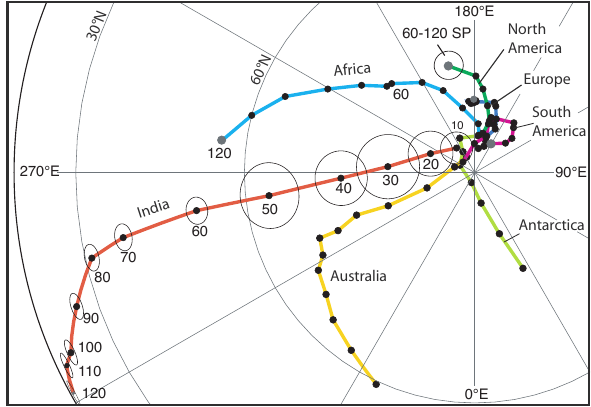
Fig. 2. Apparent polar wander paths for Africa, Antarctica, Aus- tralia, Eurasia, India, North America and South America based on a composite APWP using paleopoles from all the main continents that were brought to common coordinates using finite rotation poles used by Besse and Courtillot (2002), averaged with a sliding 20Myr window every 10Myr, and the mean poles transferred back to the different continents; hence the differences in APWP for the various continents reflect relative motions according to the finite rotation poles used for the plate reconstructions. Mean paleopoles for 10 to 50Ma are from Besse and Courtillot (2002, 2003); mean paleopole for 60 to 120Ma is an average of global igneous data (superpole la- beled 60–120Ma SP with 95% confidence circle and based on 60, 80, 100 and 120Ma mean poles from Kent and Irving, 2010) for a standstill in apparent polar wander in North American coordinates (Table 1). Circles of 95% confidence that are shown on the India APWP are in common for the APWP projected to other